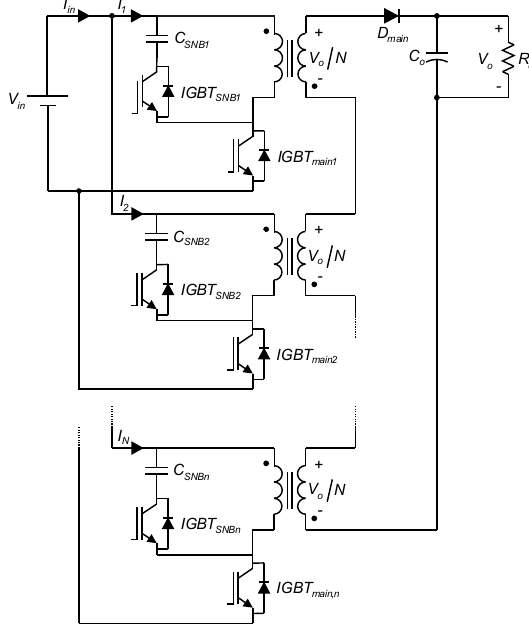
Figure 2. Proposed topology.